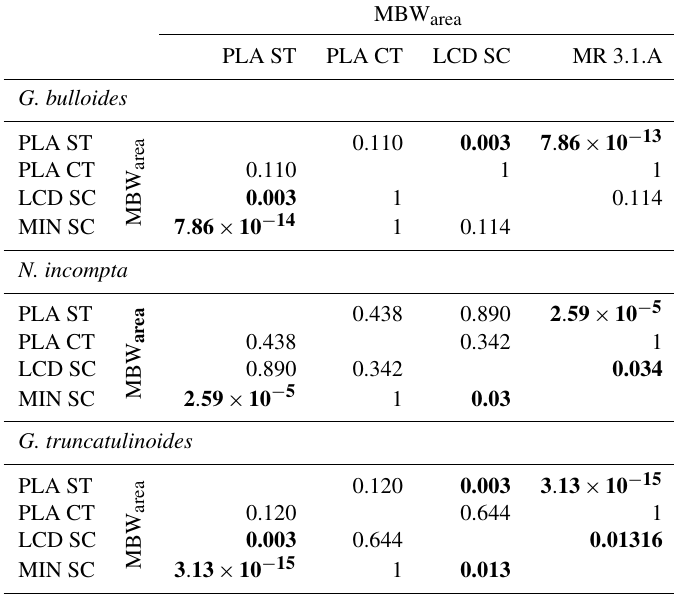
Table 4. Mann–Whitney variance test results between the MBW area of the different sites for the three species. Significant values ( p < 0.05) are set in